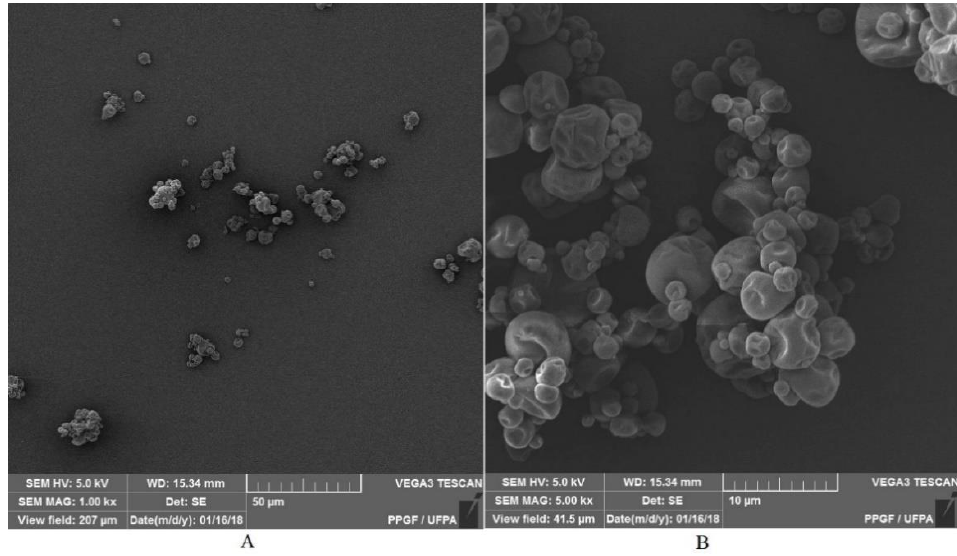
Figure 7. Microparticle photomicrographs: ( A ) (1000× magnification), ( B ) (5000× magnification).